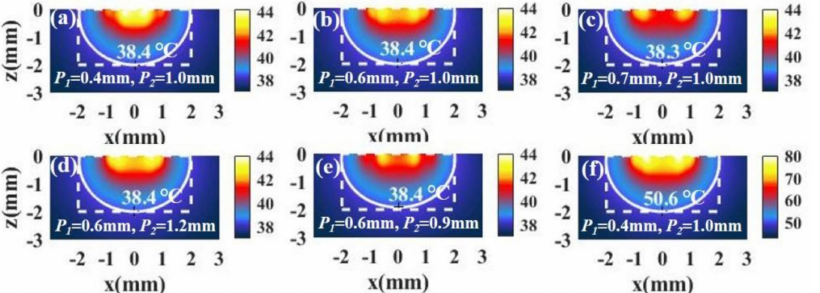
Figure 8. ( a – e ) The temperature distributions of a tumor and the surroundings with I = 15 W/cm 2 and the different positions of the inner spot P 1 and the outer spot P 2 in the case of tumor aspect ratio z/ RT = 1 ( R T = 2 mm, z = 2 mm). ( f ) The temperature distribution in the case of P 1 = 0.4 mm and P 2 = 1.0 mm with I = 90 W/cm 2